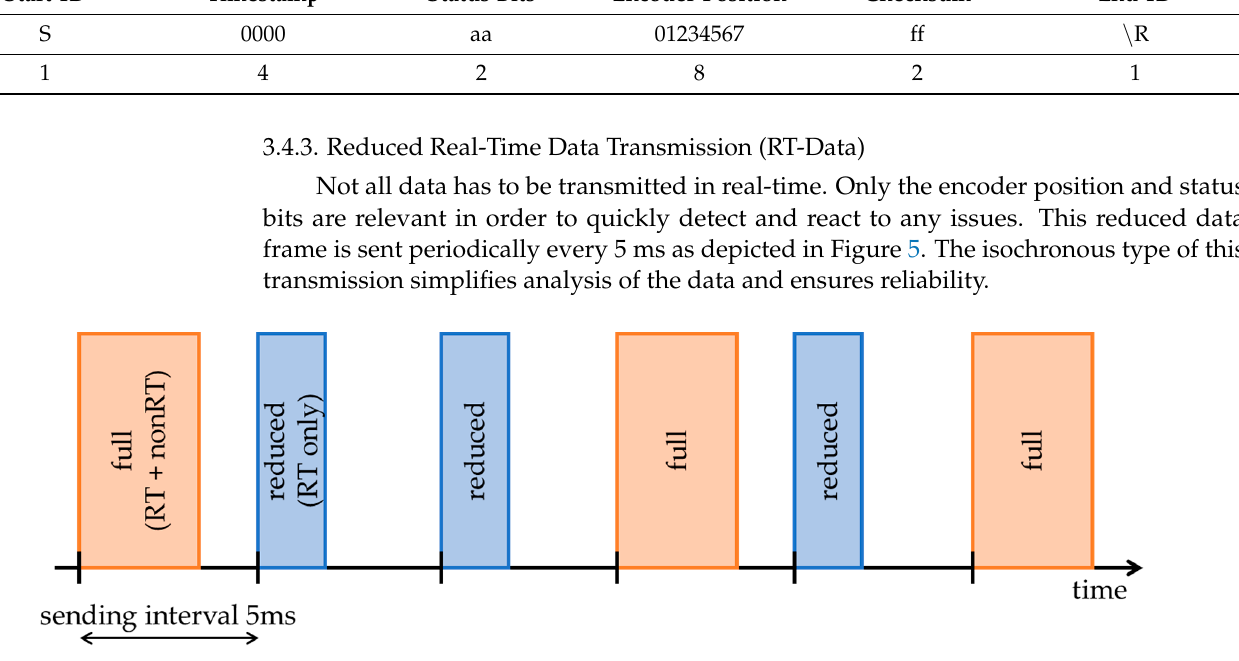
Figure 5. Whenever a full package is being sent, it replaces the reduced one. Source: R&D Steuer- ungstechnik GmbH & Co. KG. stechnik GmbH & Co.